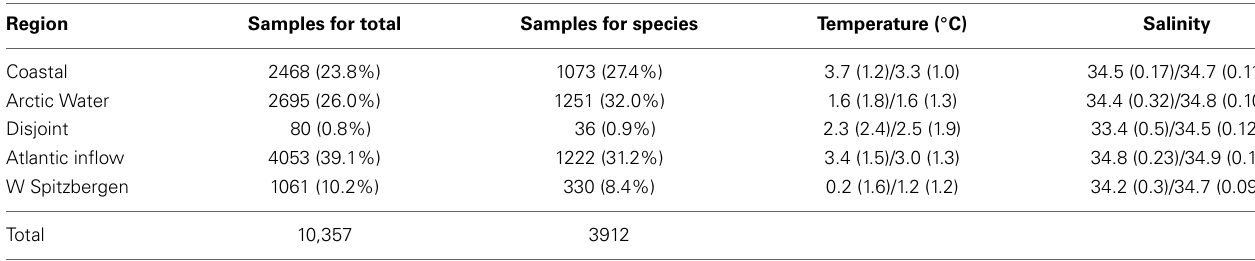
Table 1 | Number of stations (percentage of total in parentheses) for each region where total euphausiid abundance was determined (Samples for total) and where species composition was determined (Samples for